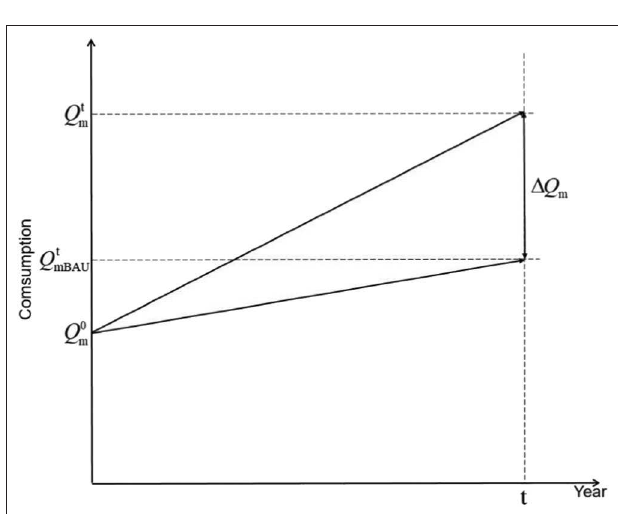
FIGURE 5 | Relationships among Q 0 m , Q t m , and Q t mBAU .